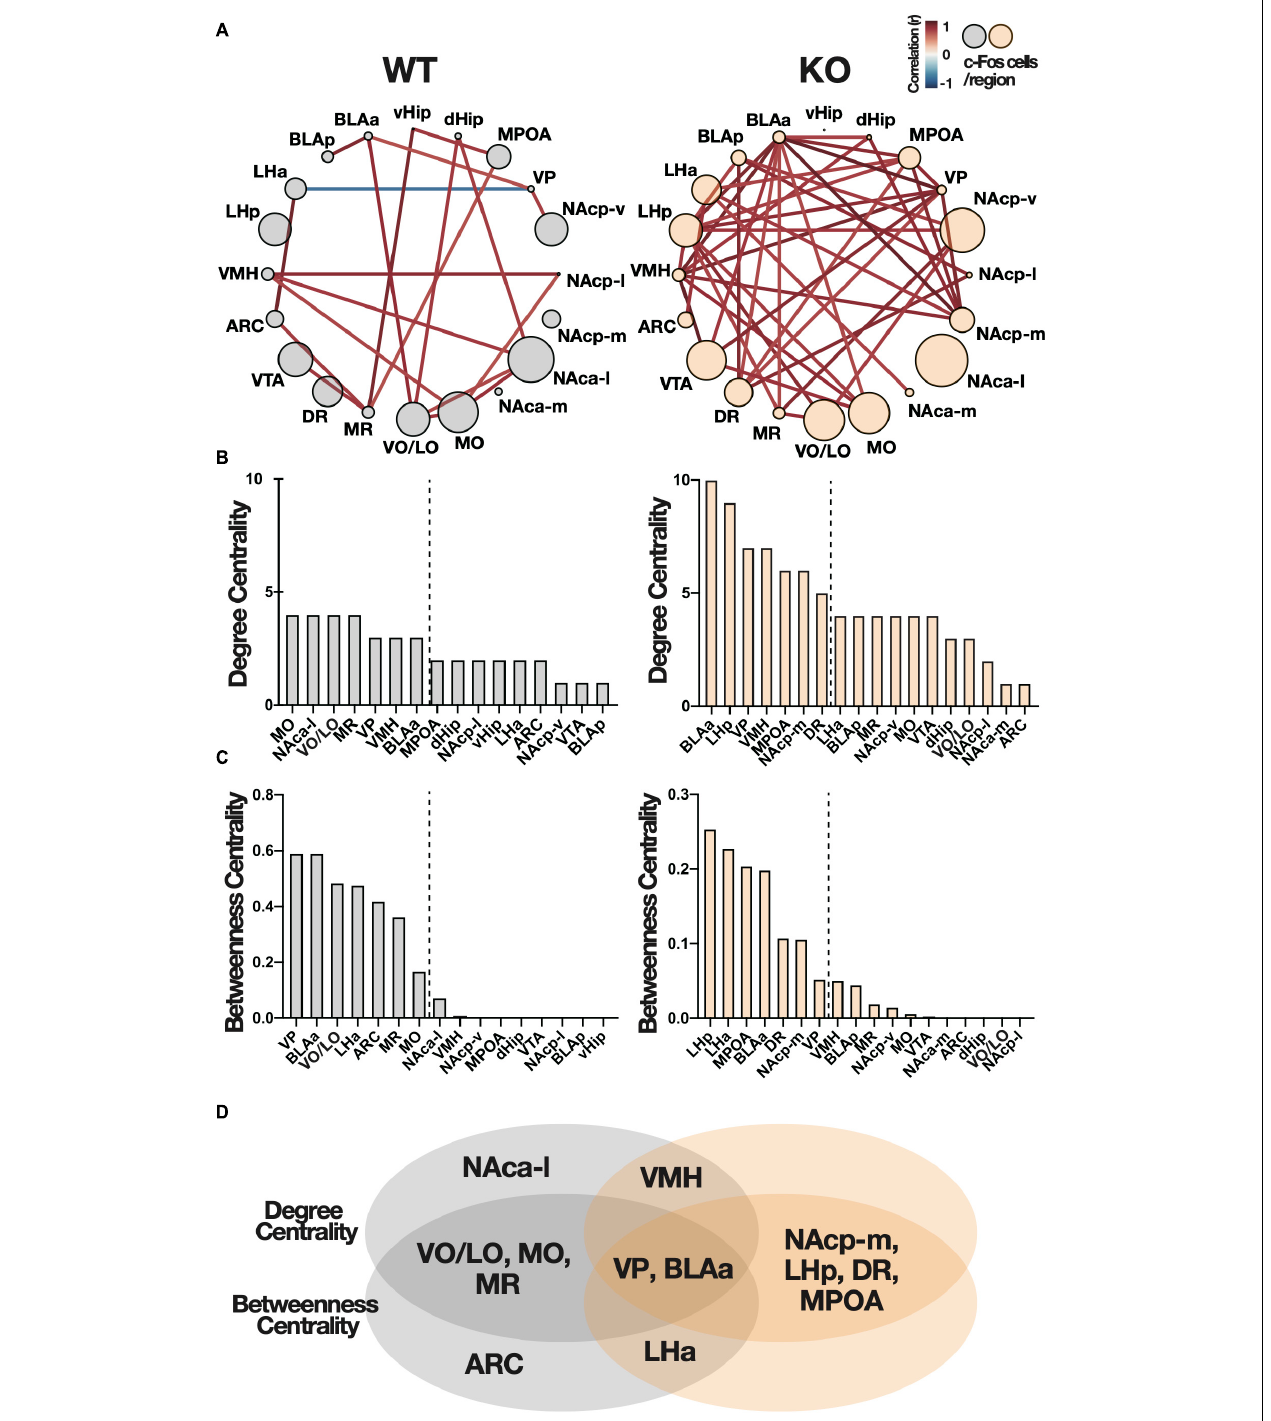
FIGURE 5 | Functional connectivity networks in the brain during the progressive ratio schedule test. (A) Networks with brain regions as nodes and inter-regional connections as edges (significant correlation coefficient: p < 0.05). The color of the edges represents the correlation coefficient and is indicated by the heat map in the top right ( Figure 2A ). The size of the node indicates the average number of c-Fos positive cells in each region. (B,C) Degree centrality and betweenness centrality of each region in the network. The broken line is the boundary of the seven regions of high centrality. (D) The Venn diagram shows the overlap in the seven regions of high centrality. ARC, arcuate nucleus; BLA, basolateral amygdala; dHip, dorsal hippocampus; DR, dorsal raphe nucleus; LH, lateral hypothalamus; MO, medial orbital area; MPOA, medial preoptic area; MR, median raphe nucleus; NAc, nucleus accumbens (a, anterior; p , posterior; m, medial; l, lateral; v, ventral), vHip, ventral hippocampus; VMH, ventromedial hypothalamic nucleus; VO/LO, ventral and lateral orbital area; VP, ventral pallidum; VTA, ventral tegmental area.